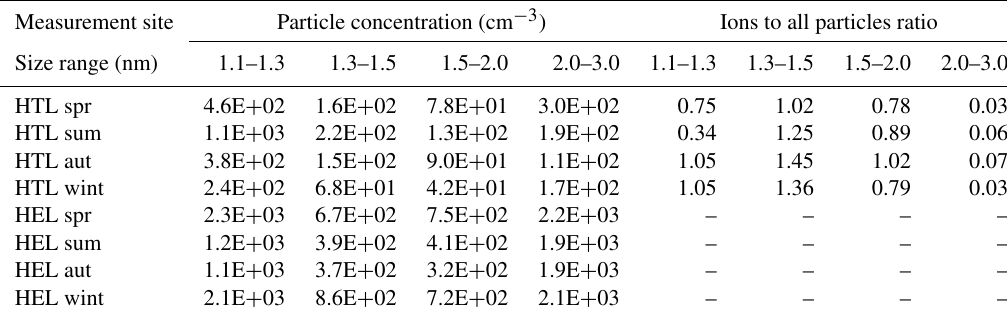
Table 4. Medians of the total particle concentration and the ratio of ion concentration to the total particle concentration in four size